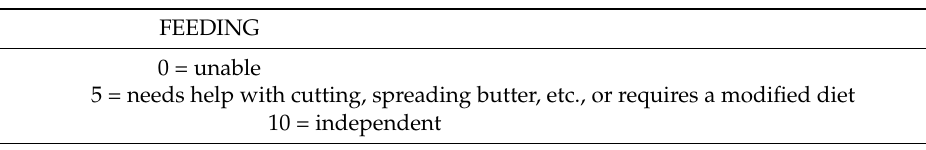
Table 4. The Barthel index for activities of daily